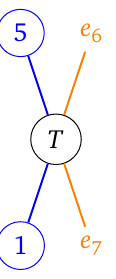
Figure 13: A portion of the cycle from Figure 10 is shown. Tensor T is the focus of this portion, and edges leading away from them towards the rest of the cycle are shown in blue connecting to blue circles (tensors) while those leading out of the cycle are shown in